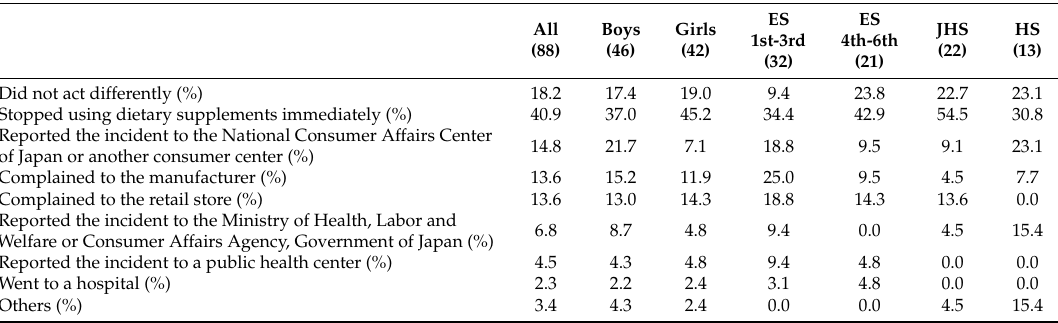
Table 8. How did you respond to the adverse